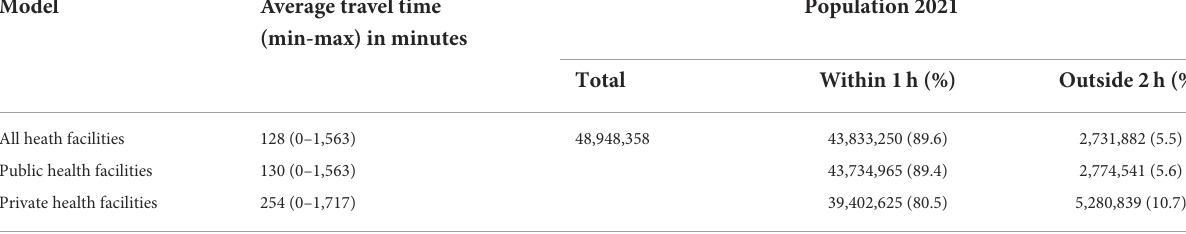
TABLE 3 The average travel time and proportion of population accessing care within 1h of the nearest facility and those marginalized (outside 2h) of public, private and all health facilities in Kenya at national level.